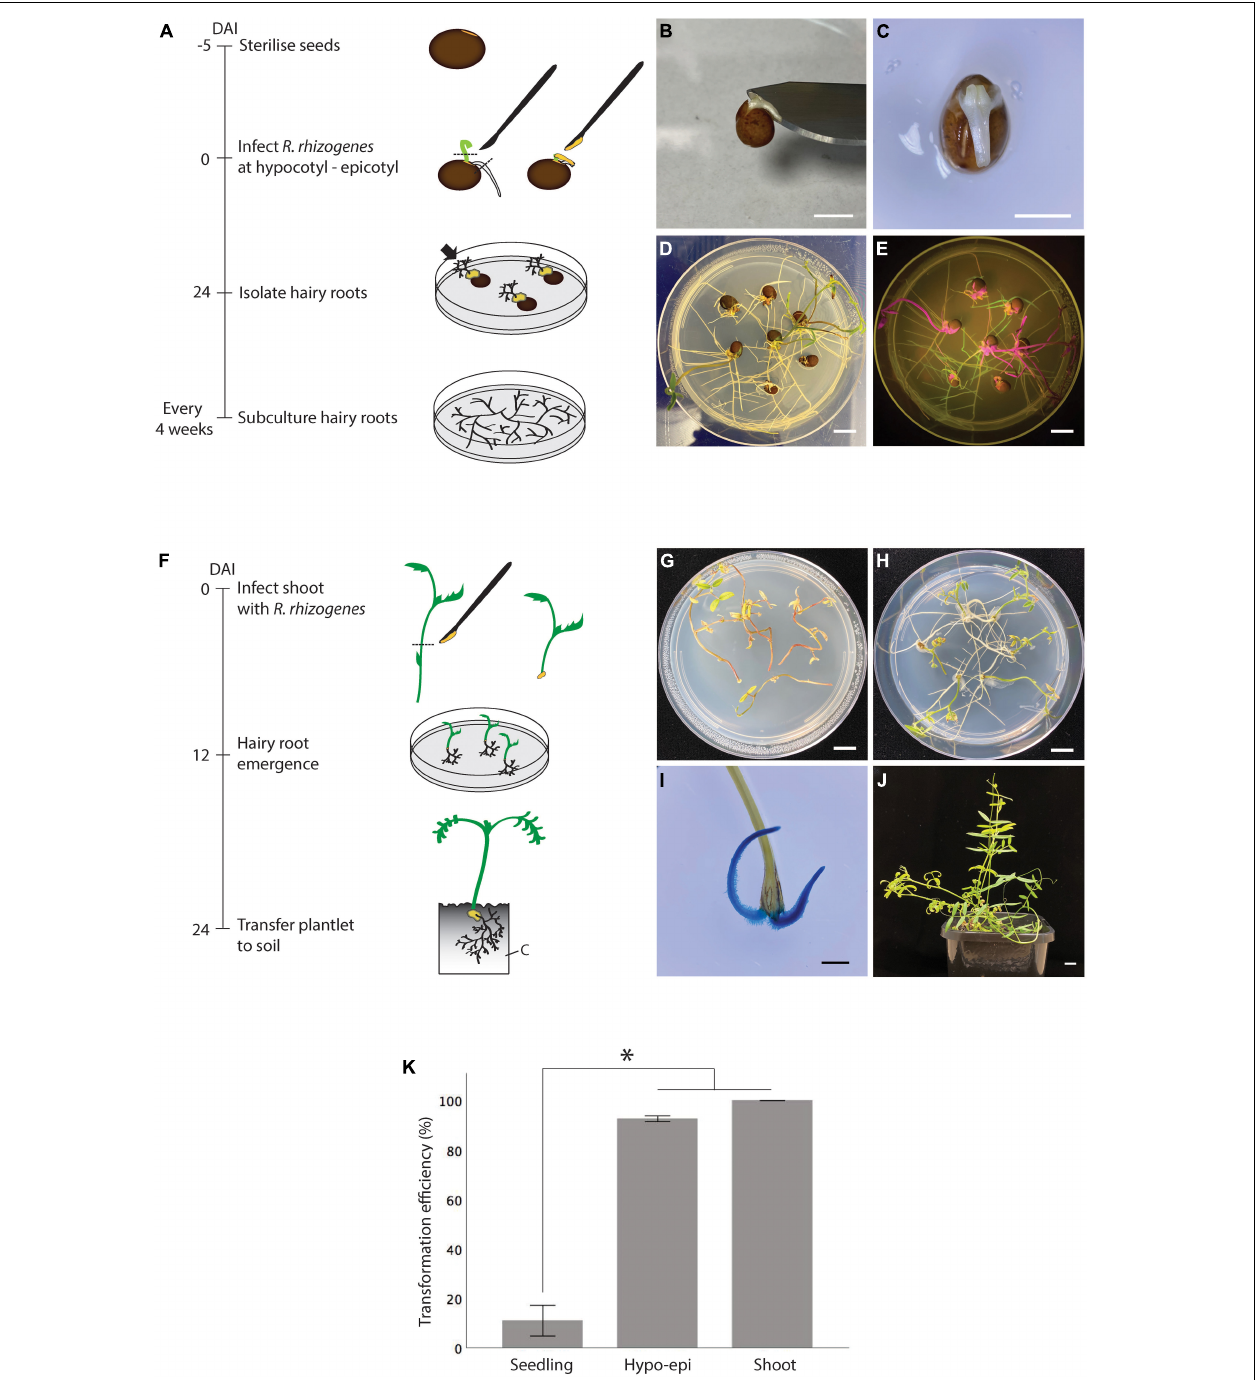
FIGURE 3 | In vitro hairy root induction from vetch hypocotyl-epicotyls and shoots by R. rhizogenes K599 using the cutting method. (A) Timeline for in vitro hairy root induction from hypocotyl-epicotyl tissues by R. rhizogenes . On day 1, sterilized seeds were sown on a plate containing RGM_NoSuc medium and germinated at 25 ◦ C. On day 5, primary shoots and roots of the seedlings were trimmed off, and hypocotyl-epicotyl regions were infected with R. rhizogenes by making a longitudinal cut with a surgical knife containing the bacterial paste. Infected explants were cultured on RGM_NoSuc medium under fluorescent light at 25 ◦ C. Twenty-four days after the infection (DAI), hairy roots were isolated and subcultured. The black arrow indicates hairy root growth from the inoculation site. (B) After trimming off a primary root and shoot, the remaining hypocotyl-epicotyl attached to the seed was infected by cutting longitudinally into the middle part of it with a surgical blade carrying the bacteria. (C) View from above of a hypocotyl-epicotyl explant after the infection. (D) Hairy root formation from the infected hypocotyl-epicotyl explants at 24 DAI. (E) GFP-expressing transgenic hairy roots (green color) were detected using a hand-held blue light (Dark Reader Lamp –